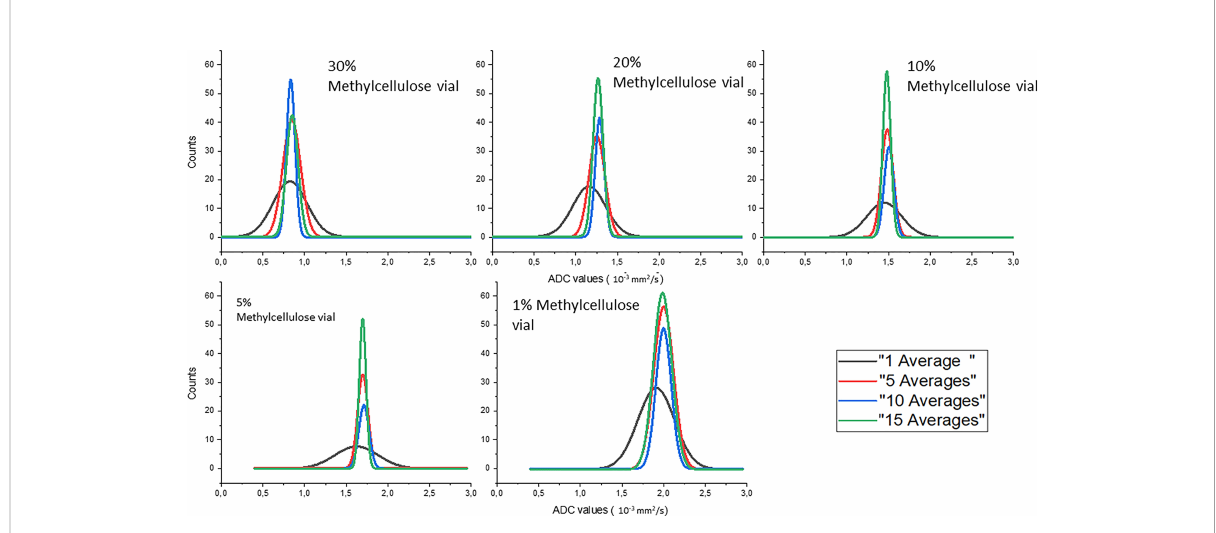
FIGURE 4 Gaussian fi ts of the distributions of the ADC values of the different concentrations of methylcellulose in the HMP obtained for different numbers of averages.